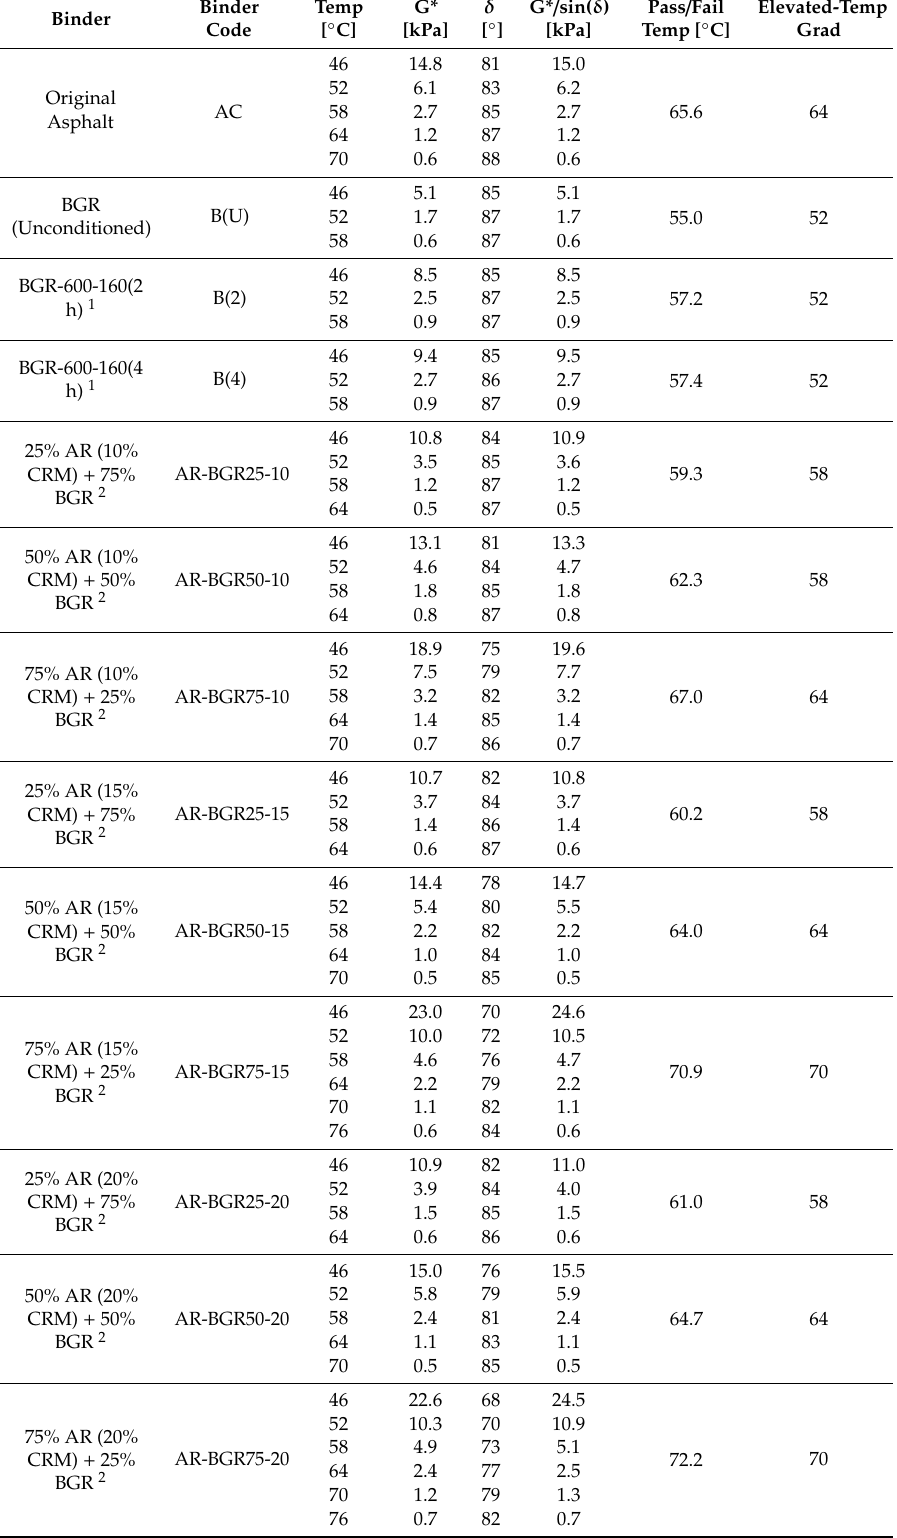
Table 2. Superpave grading of unaged binders at elevated